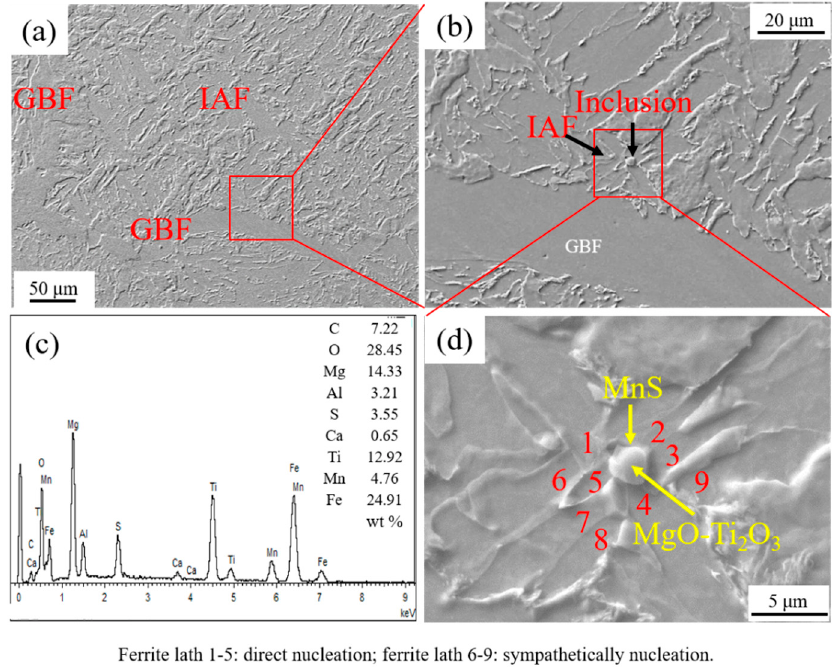
Figure 5. Intragranular acicular ferrites (IAFs) nucleated by intragranular inclusion nearby grain boundary ferrite (GBF) in HAZ of experimental steel LM. ( a ) HAZ microstructure, ( b ) inclusion, ( c ) energy dispersive spectrometer (EDS) analysis result of inclusion, and ( d ) component of inclusion.